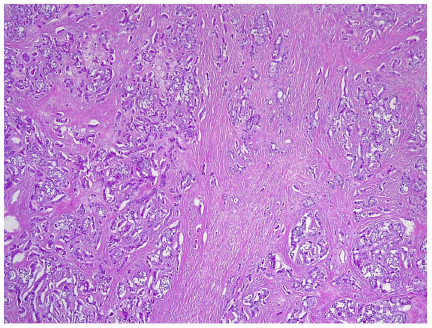
Figure 9. Strumal carcinoid. HE, 10 × .